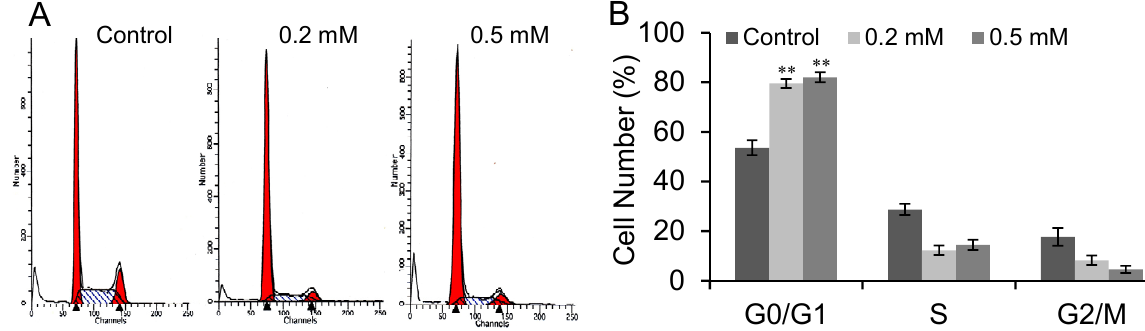
Figure 3. SVP induced cell cycle arrest in Bel-7402 cells. Bel-7402 cells were treated with 0.2 and 0.5 mM SVP for 120 h, and cell cycle distribution were detected by flow cytometric analysis ( A ), and expressed as mean ± S.D. ( B ) Data shown are representative of three independent experiments. ** p < 0.01, versus control